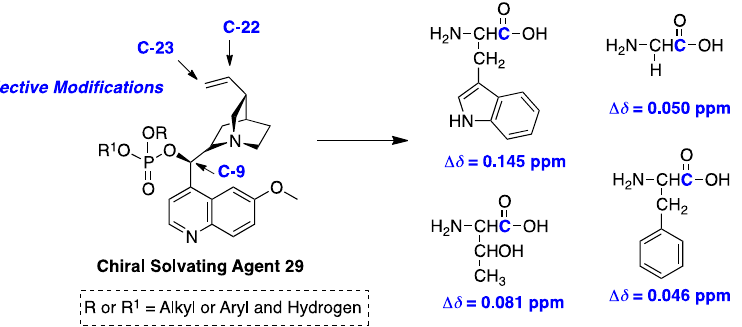
Scheme 22. Chiral discrimination of amino acid derivative by 13 C { 1 H} NMR spectroscopy.